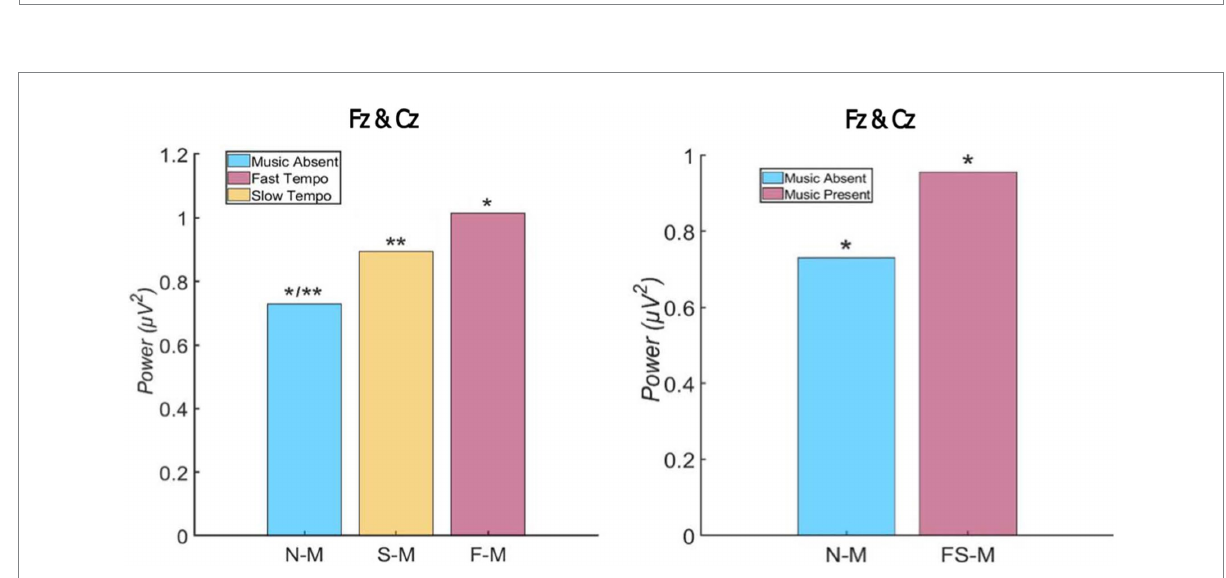
FIGURE 3 Event-related potential (ERP) inhibition level by condition (*, **denote statistically significant differences).